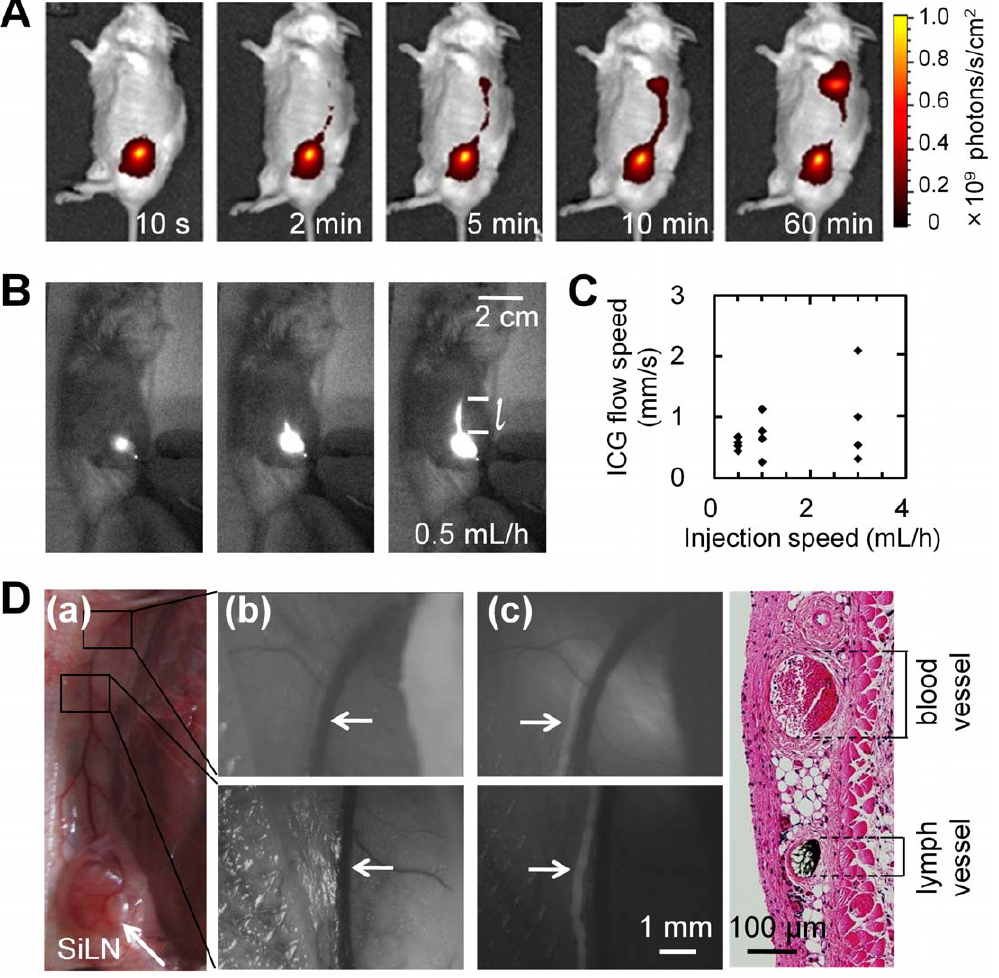
Figure 1. Metastatic flow and route. A. ICG flow from the SiLN to the proper-ALN, observed using an in vivo fluorescence imaging system (IVIS; n =1). B. Representative PDE images, following an ICG injection speed of 0.5 mL/h. The speed of ICG flow was calculated by dividing the distance, l , by the duration of time that had elapsed post-injection. C. Graph of the relationship between ICG flow speed and intra-SiLN injection speed (low, 0.5; medium, 1.0; high, 3.0 mL/h; n =4 per group), revealing a low level of variation between individual experiments in the low-speed group. D. HS-FVCS image of the afferent lymphatic vessels after intra-SiLN injection of FITC-BSA solution ( n =2). ( a ) Area near the SiLN and proper-ALN captured by a normal digital camera. Two regions of interest were selected. ( b ) Bright field images obtained by HS-FVCS, without use of a fluorescence filter. A thick superficial epigastric vein ( R ) was observed. ( c ) Fluorescence images obtained by HS-FVCS, with use of an appropriate fluorescence filter (bandwidth: 510 6 2 nm). A new flow channel filled with FITC-BSA solution ( R ) appeared at a distance of about 200 m m from the vein. ( d ) Results of hematoxylin and eosin (H&E) staining. The flow channel was identified as the afferent lymphatic vessels by injection of Indian ink. The vein was not stained ( n =1).